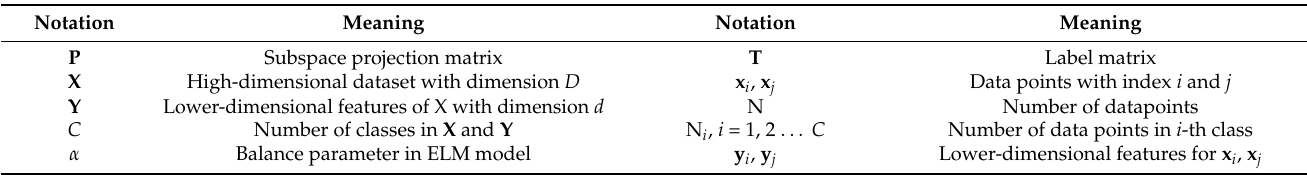
Table 2. Important notations used in this